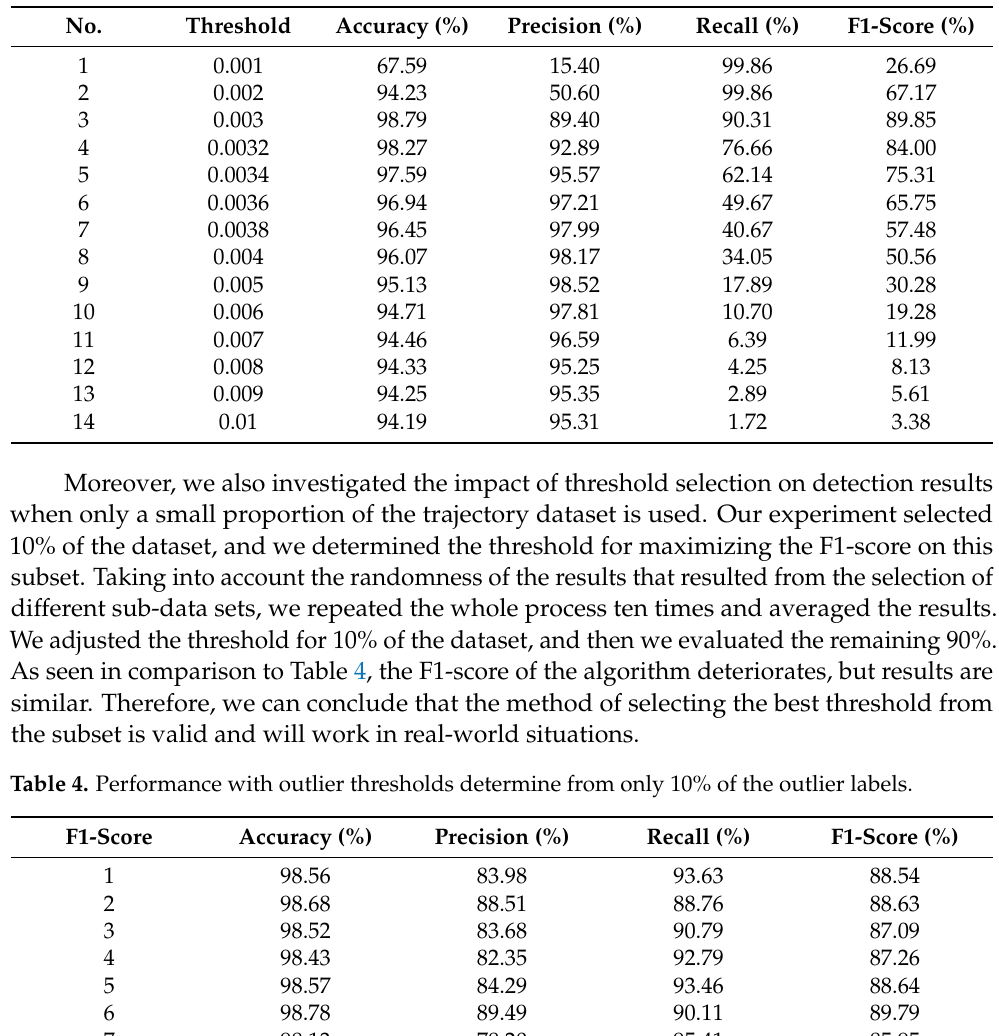
Table 3. Performance with different outlier thresholds.